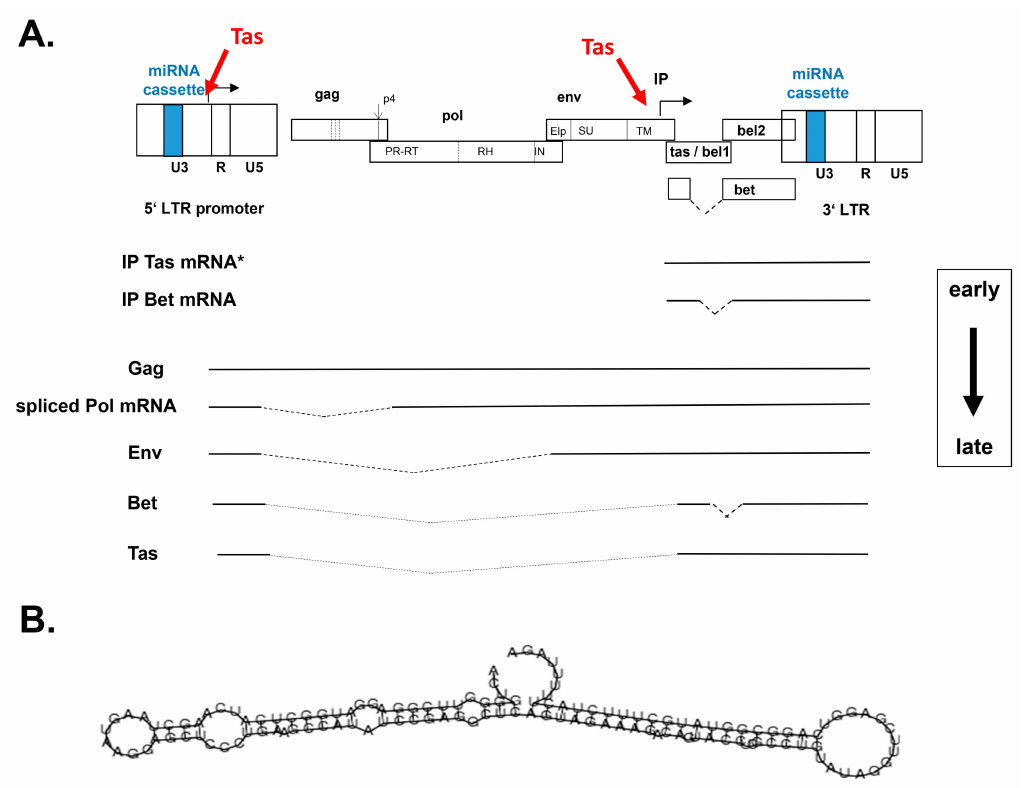
Figure 2. Genetic structure and schematic illustration of bovine foamy virus (BFV) gene expression and the BFV primary miRNA. ( A ) The BFV provirus DNA genome is shown on top schematically and out of scale with the terminal long terminal repeats (LTRs) consisting of the U3, R, and U5 regions. The position of the miRNA cassette in the U3 regions is indicated in color. BFV genes are shown as overlapping open boxes sub-divided into the mature protein domains. Proteolytic processing is marked by dotted lines. The spliced bet gene is separately shown below the genome. Broken arrows indicate the transcriptional start sited and direction of LTR- and internal promoter- (IP) directed gene expression and the Tas-mediated transactivation of the 5’LTR and the IP is indicated in red. Below, a selection of the major early and late BFV transcripts starting at the IP and LTR are shown with spliced-out areas indicated by broken lines. Only the major BFV IP-directed Tas mRNA is shown (*). The shift between early and late transcription is marked by a boxed arrow at the right-hand margin. ( B ) The predicted folding and secondary structure of the BFV dumbbell-shaped miRNA precursor (BFV pri-miRNA) is given, for additional information, and the sequence of the mature and stable miRNA, see below and Whisnant et al., 2014